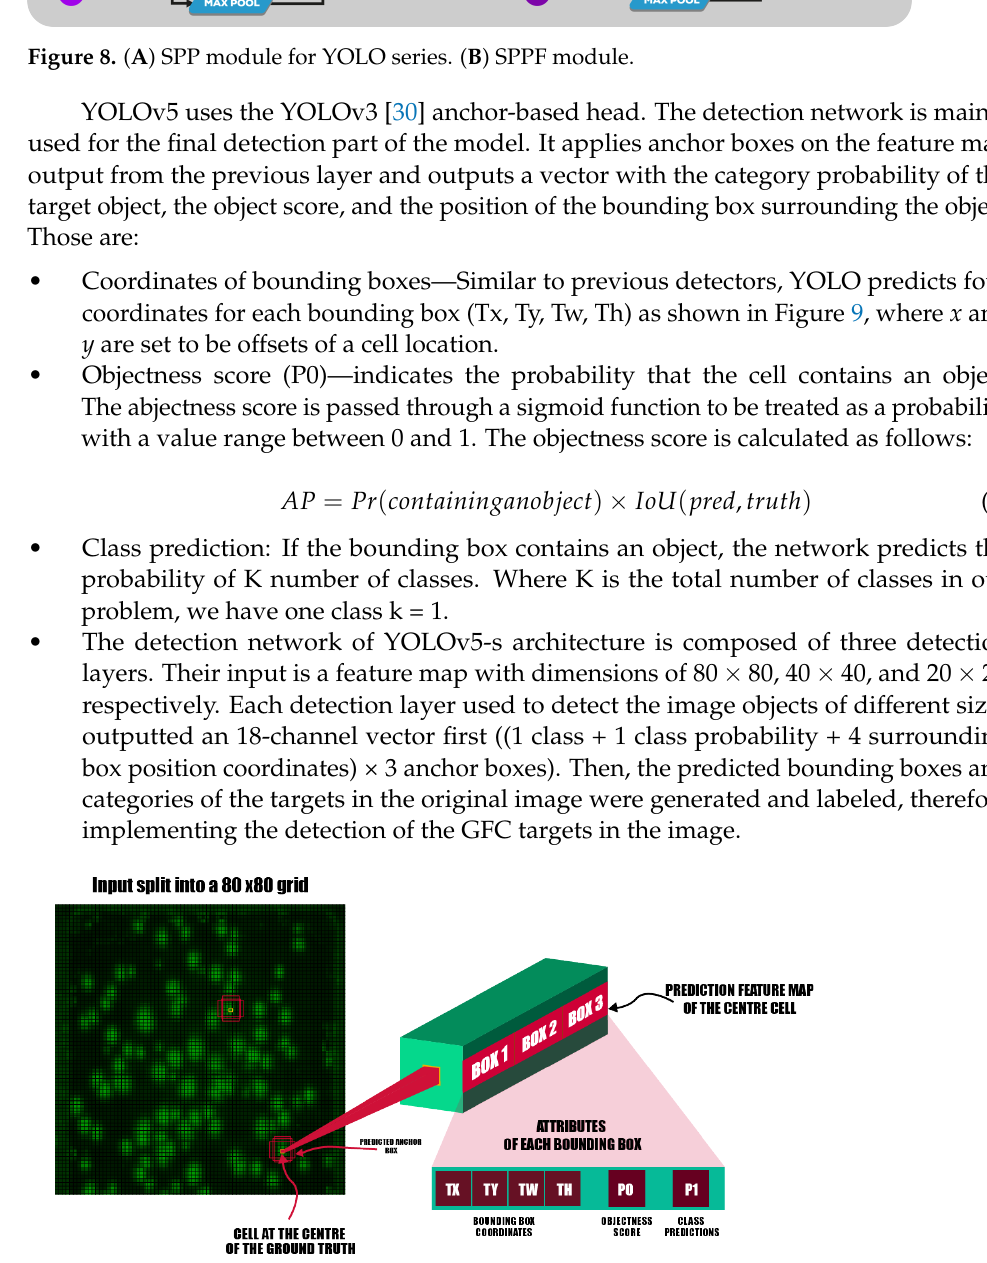
Figure 9. Example of a YOLOv5 workflow when applying a 80 × 80 grid to the input image. The input image is split into 3600 grid cells. Each grid cell predicts 3 bounding boxes and their objectness score along with their class